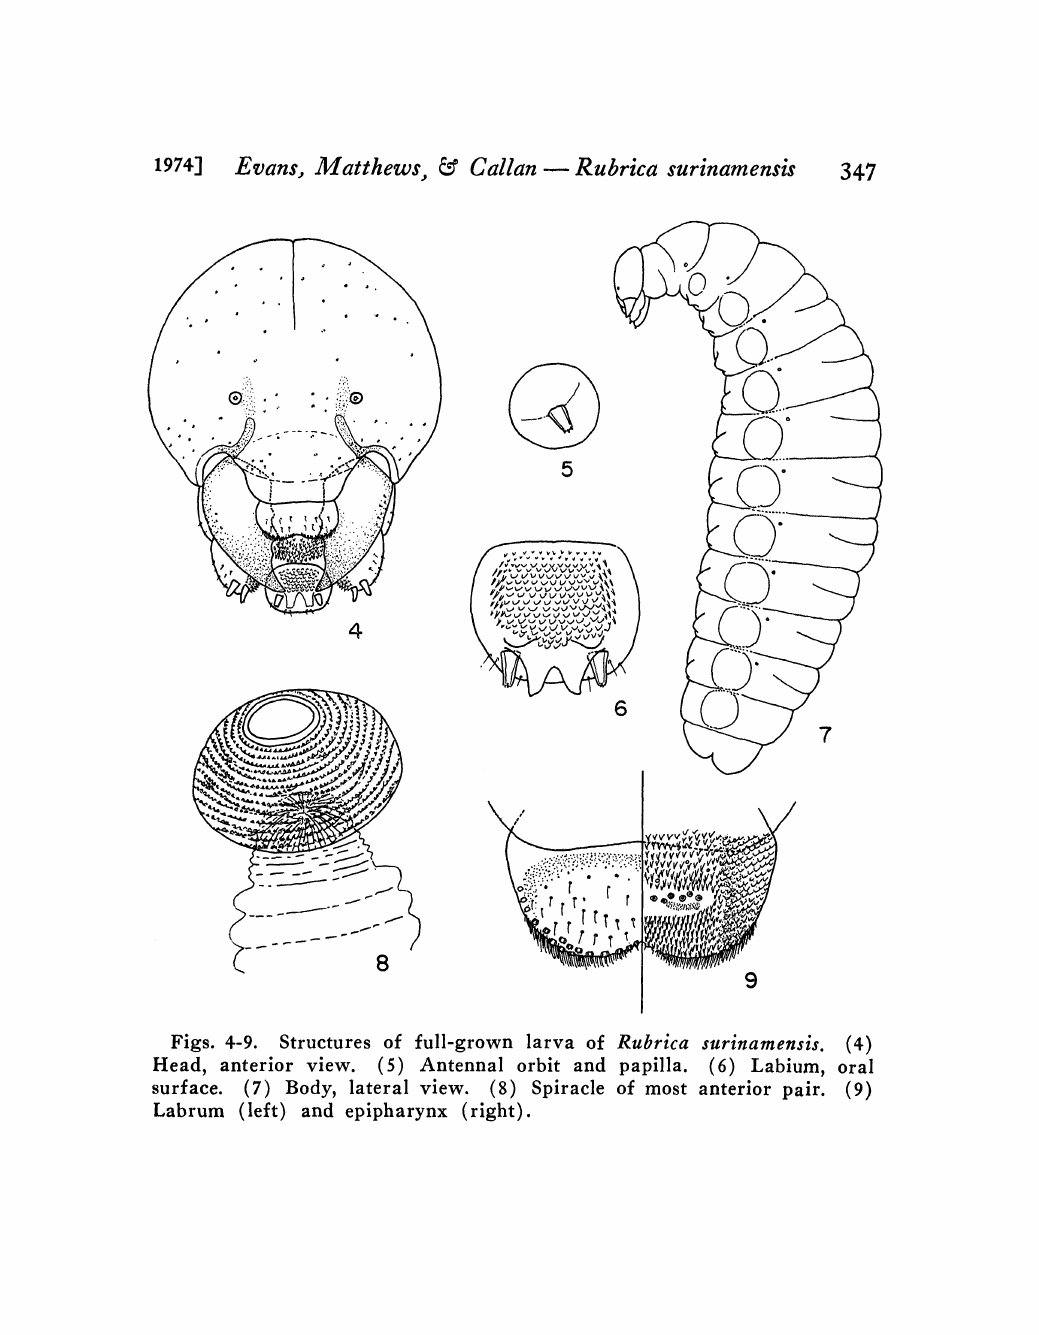
Figs. 4-9. Structures of full-grown larva of Rubrica surinamensis. (4) Head, anterior view. (5) .Antennal orbit and papilla. (6) Labium, oral surface. (7) Body, lateral view. (8) Spiracle of most anterior pair. (9) Labrum (left) and epipharynx